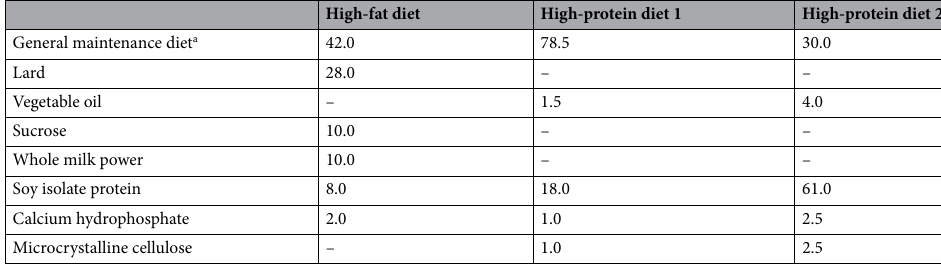
Table 1. Compositions of the rat diets (g/100 g diet). a The compositions of the general maintenance diet were: corn 40.6%, middling 14.0%, wheat 10.0%, clover 3.0%, soybean meal 11.0%, fish meal 6.0%, chicken meal 6.0%, a mixture of vitamins and minerals 4.4%, wheat gluten 2.0%, stone power for feed 1.0% and salad oil